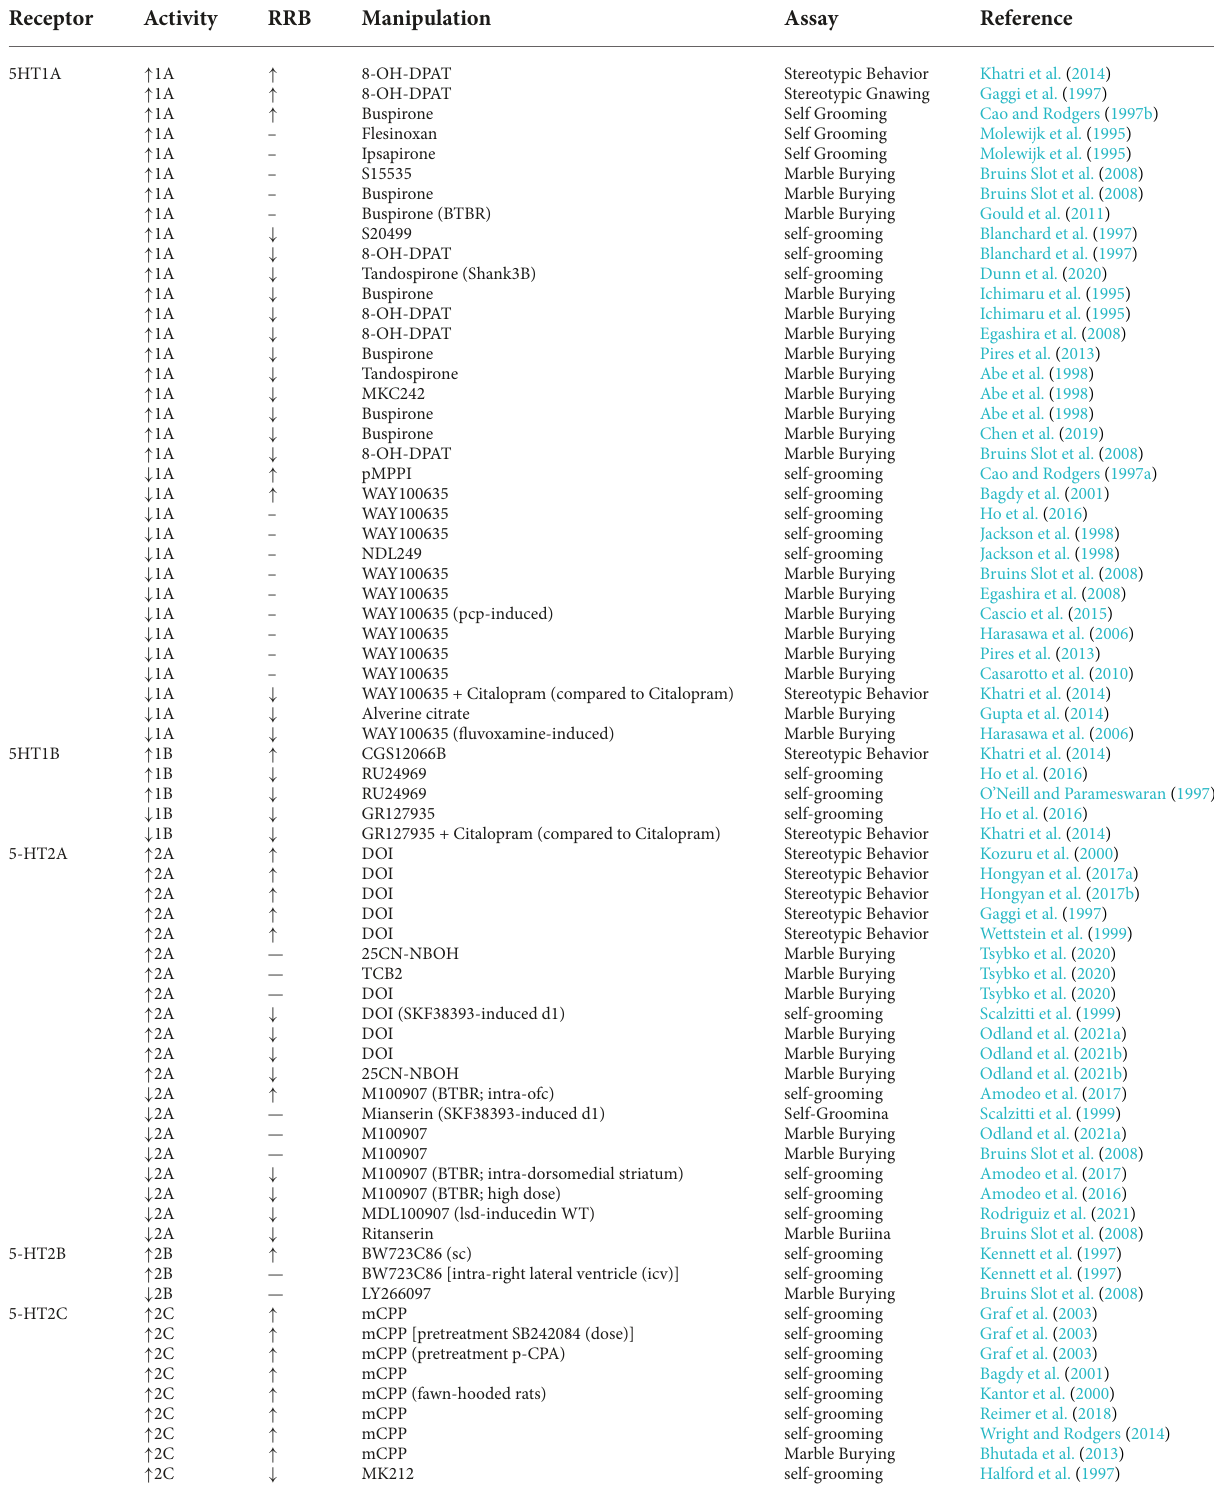
Receptor Activity RRB Manipulation Assay